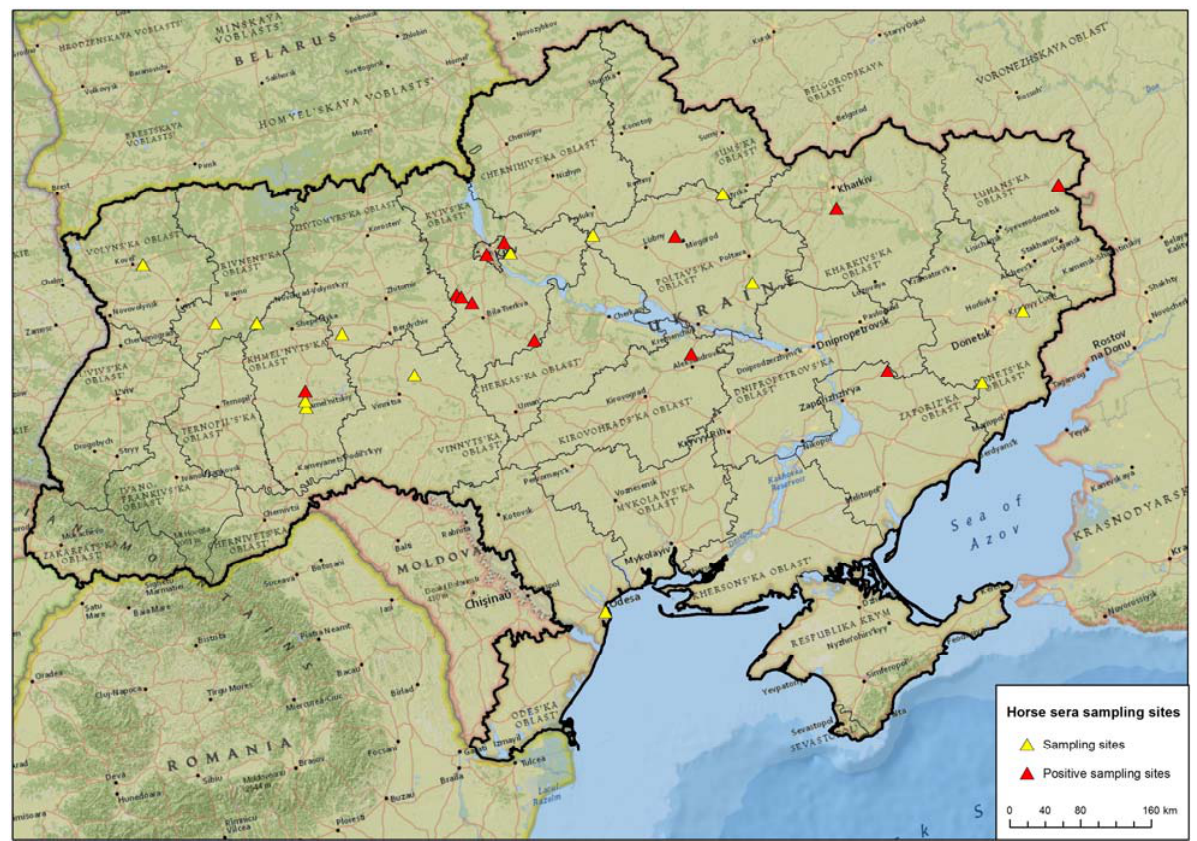
Figure 1. Sampling sites of the horse sera with focus on known WNV risk